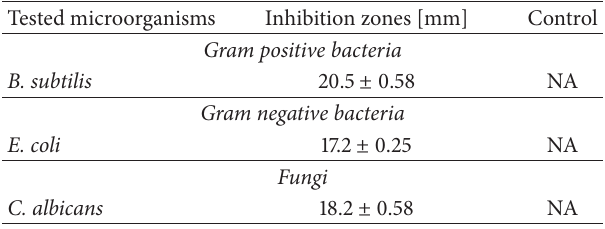
Figure 8: PAA/Ag nanocomposite inhibition zones against E. coli as example. Table 1: Antimicrobial activity of prepared colloids by diffusion agar technique, well diameter: 6.0 mm of tested materials, inhibition zones measured in mm.